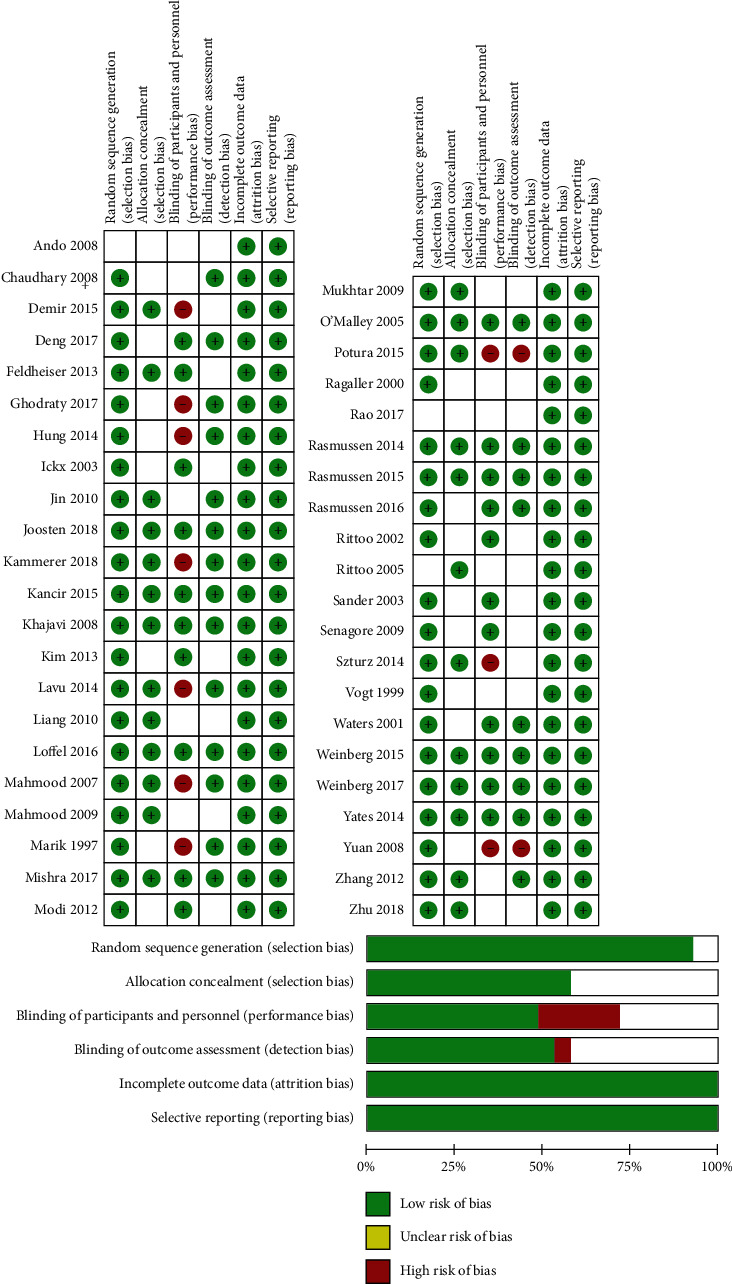
Risk of bias of original studies.